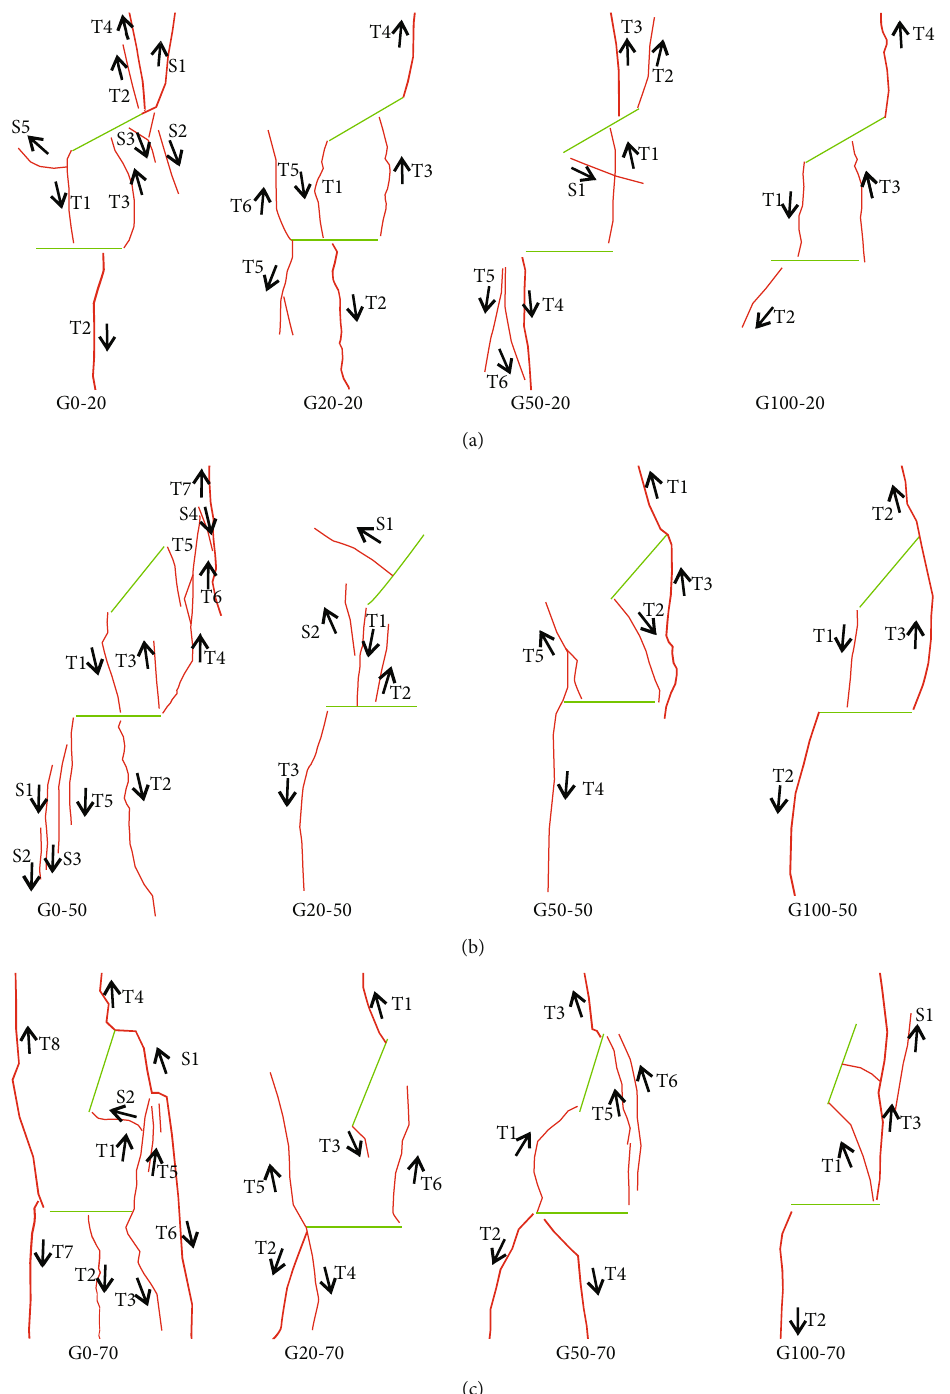
Figure 10: Sketch of the crack coalescence pattern observed around the rock bridge segment in the granite samples: (a) Samples have an inclined fl aw of 20 ° subjected to 0, 20, 50, and 100 F-T cycles. (b) Samples have an inclined fl aw of 50 ° subjected to 0, 20, 50, and 100 F-T cycles. (c) Samples have an inclined fl aw of 70 ° subjected to 0, 20, 50, and 100 F-T cycles. The thick green lines represent the fl aws, and the thin red lines denote the cracks emanating from the fl aws. The shear cracks and tensile cracks are marked with S and T, respectively, with the following subscript number denoting the order of